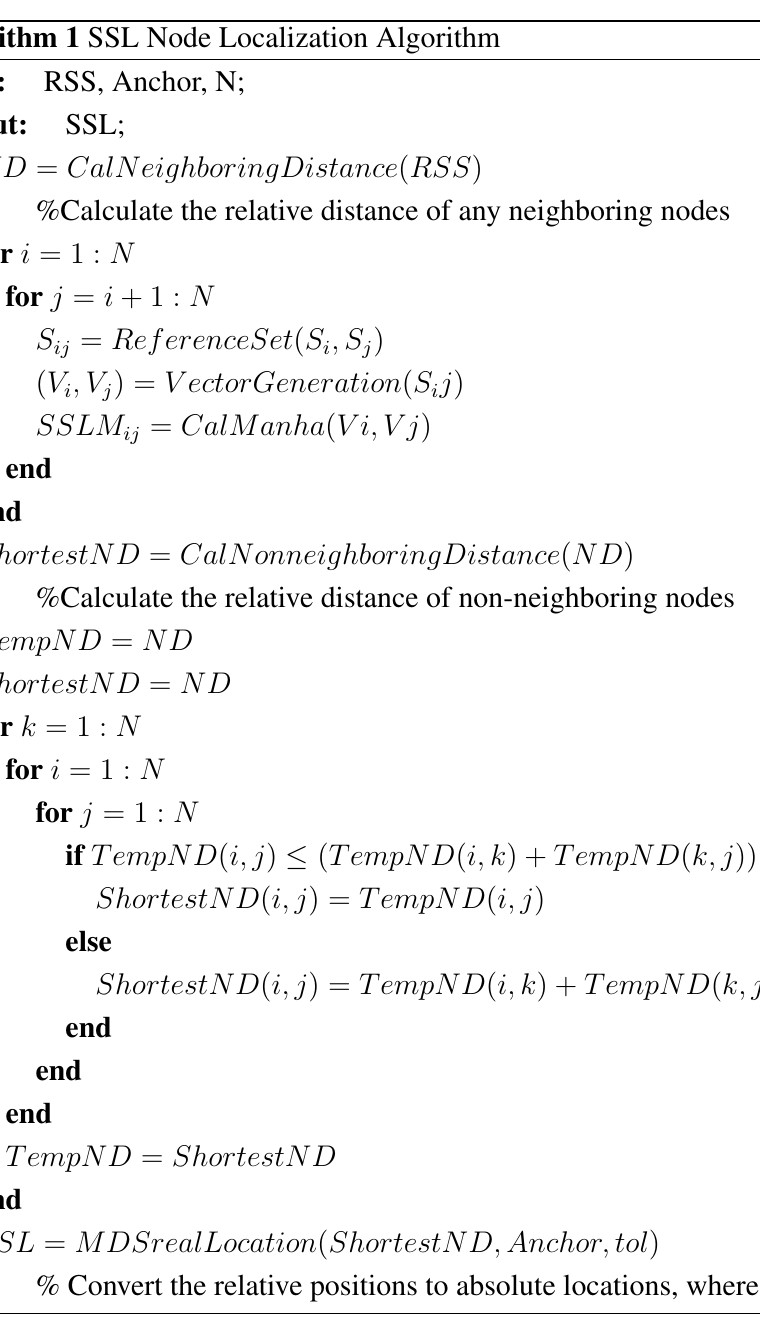
Algorithm 1 SSL Node Localization